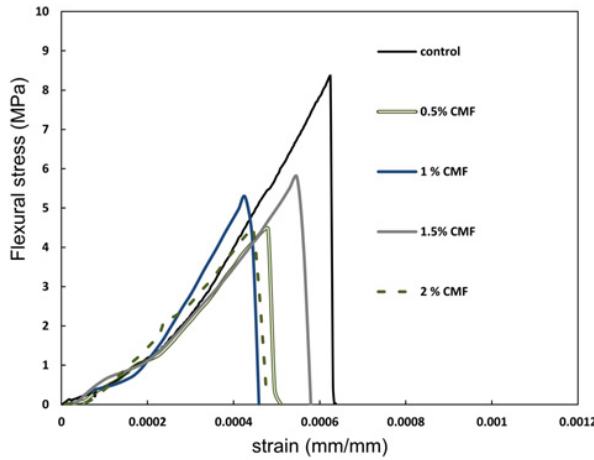
Fig. 5. Stress-strain curve of cementitious composites containing cellulose